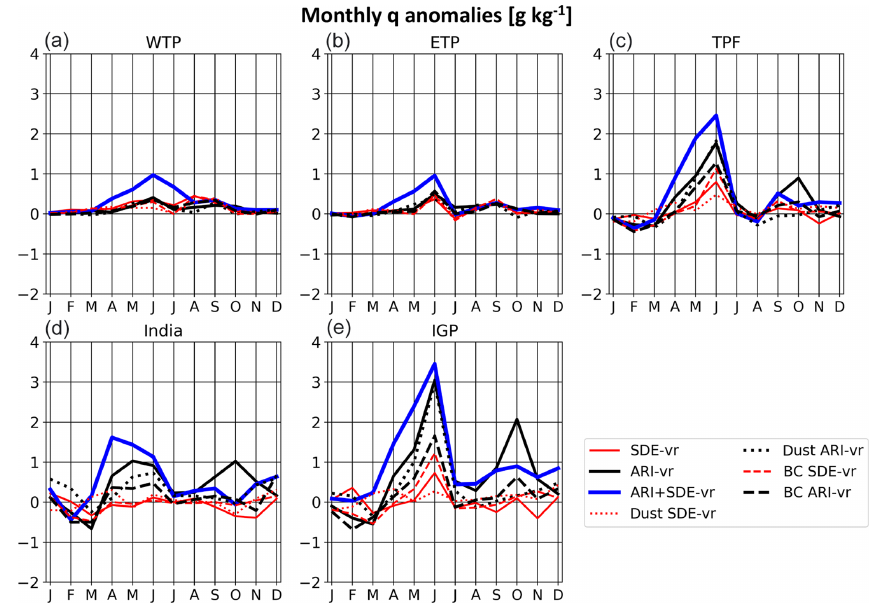
Figure 9. Monthly time series of specific humidity ( q ) changes in grams per kilogram due to BCD effects across (a) WTP, (b) ETP, (c) TPF, (d) India, and (e)